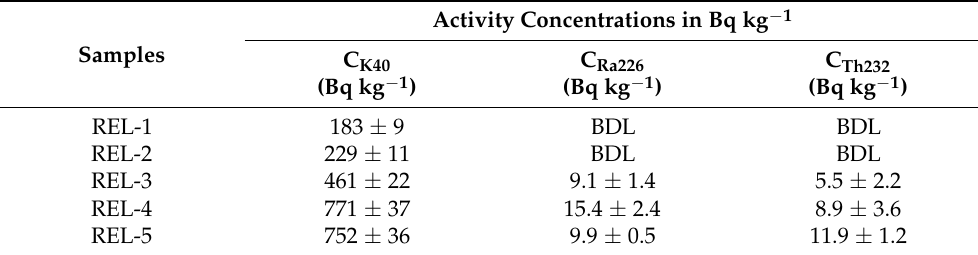
Table 3. Activity concentrations of 226 Ra, 232 Th, and 40 K (Bq kg − 1 ) in mining tailing samples.